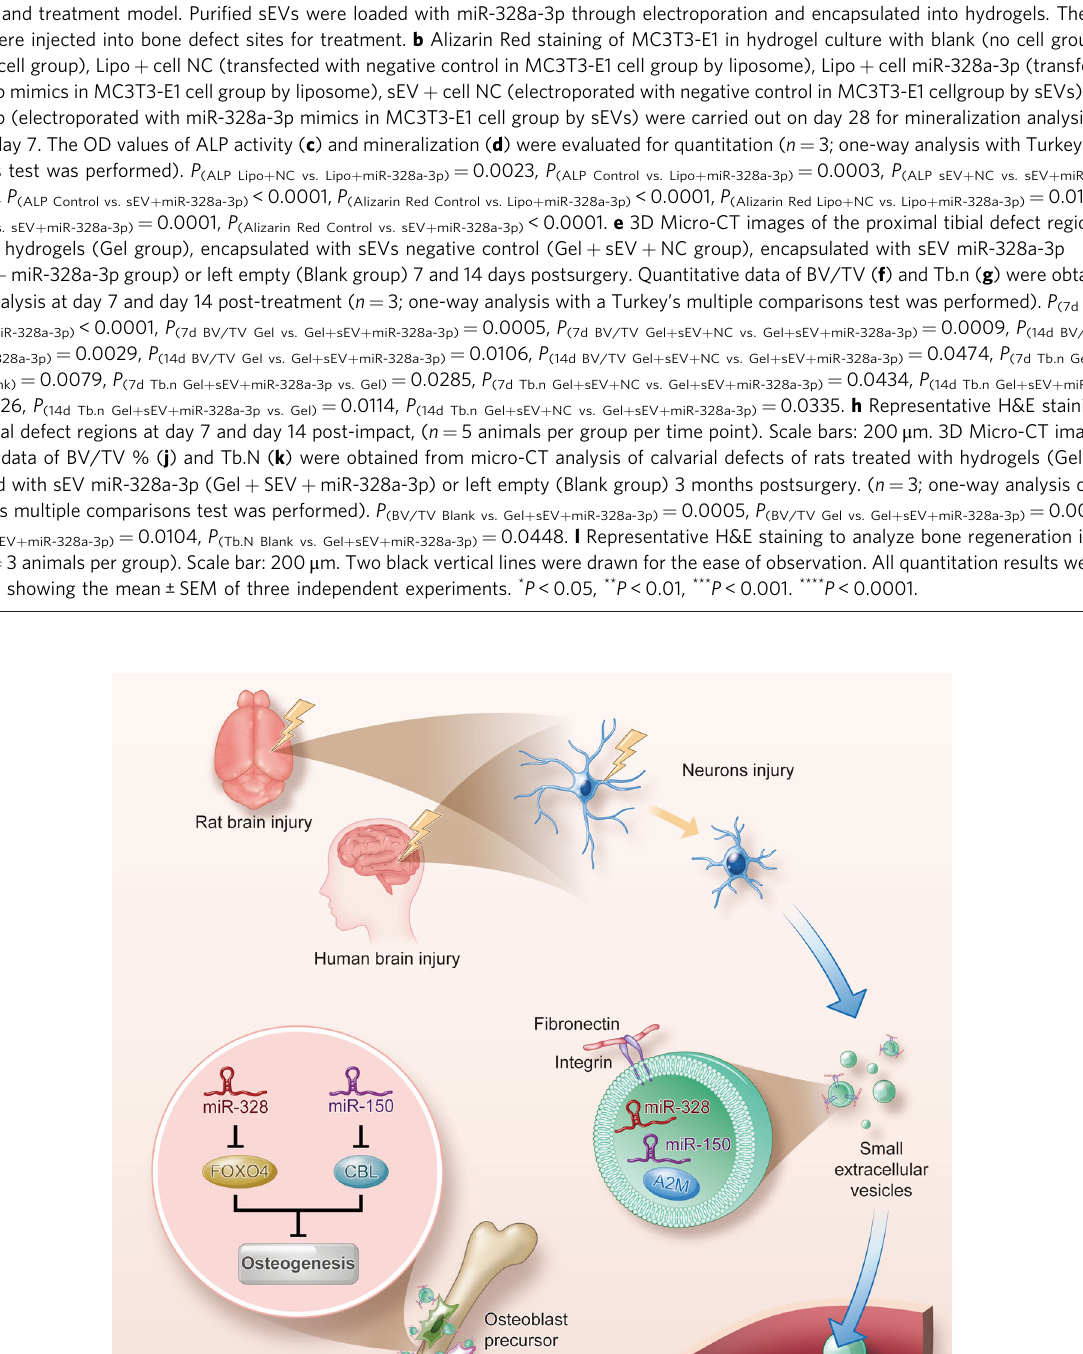
Fig. 7 Hydrogel carrying miR-328a-3p-containing sEVs ef fi ciently promotes bone formation and repairs bone defects. a Schematic representation of sEV loading and treatment model. Puri fi ed sEVs were loaded with miR-328a-3p through electroporation and encapsulated into hydrogels. Then, the hydrogels were injected into bone defect sites for treatment. b Alizarin Red staining of MC3T3-E1 in hydrogel culture with blank (no cell group), cell (MC3T3-E1 cell group), Lipo + cell NC (transfected with negative control in MC3T3-E1 cell group by liposome), Lipo + cell miR-328a-3p (transfected with miR-328a-3p mimics in MC3T3-E1 cell group by liposome), sEV + cell NC (electroporated with negative control in MC3T3-E1 cellgroup by sEVs), sEV + cell miR-328a-3p (electroporated with miR-328a-3p mimics in MC3T3-E1 cell group by sEVs) were carried out on day 28 for mineralization analysis and ALP staining on day 7. The OD values of ALP activity ( c ) and mineralization ( d ) were evaluated for quantitation ( n = 3; one-way analysis with Turkey ’ s multiple comparisons test was performed). P (ALP Lipo + NC vs. Lipo + miR-328a-3p) = 0.0023, P (ALP Control vs. Lipo + miR-328a-3p) = 0.0003, P (ALP sEV + NC vs. sEV + miR-328a- P P P = 0.015, P (ALP Control vs. sEV + miR-328a-3p) < 0.0001, (Alizarin Red Control vs. Lipo + miR-328a-3p) < 0.0001, (Alizarin Red Lipo + NC vs. Lipo + miR-328a-3p) (Alizarin 3p) < 0.0001, = 0.0001, P (Alizarin Red Control vs. sEV + miR-328a-3p) < 0.0001. e 3D Micro-CT images of the proximal tibial defect regions of rats Red sEV + NC vs. sEV + miR-328a-3p) treated with hydrogels (Gel group), encapsulated with sEVs negative control (Gel + sEV + NC group), encapsulated with sEV miR-328a-3p micro-CT analysis at day 7 and day 14 post-treatment ( n = 3; one-way analysis with a Turkey ’ s multiple comparisons test was performed). P (7d BV/TV Blank